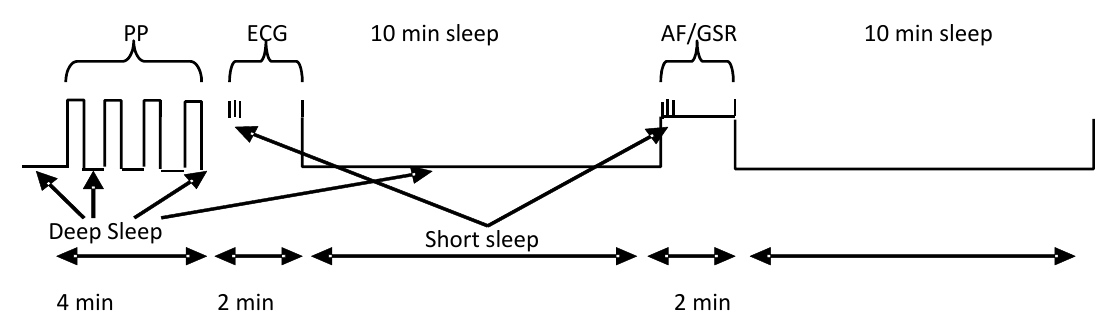
Figure 7. Description of sampling and sleep modes during the case study.